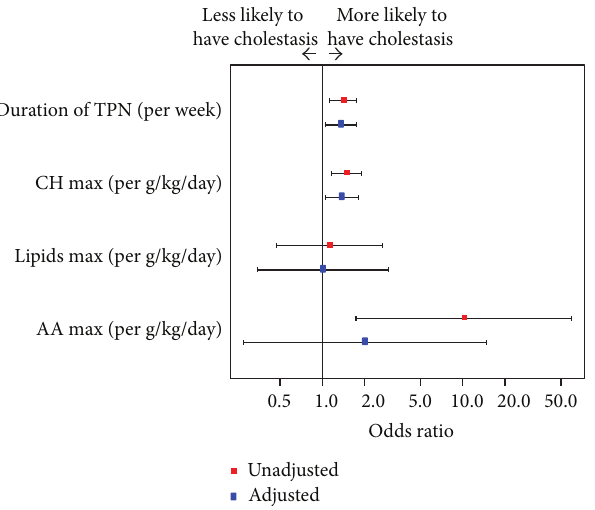
Figure 1: Unadjusted and adjusted odds ratios from logistic regres-